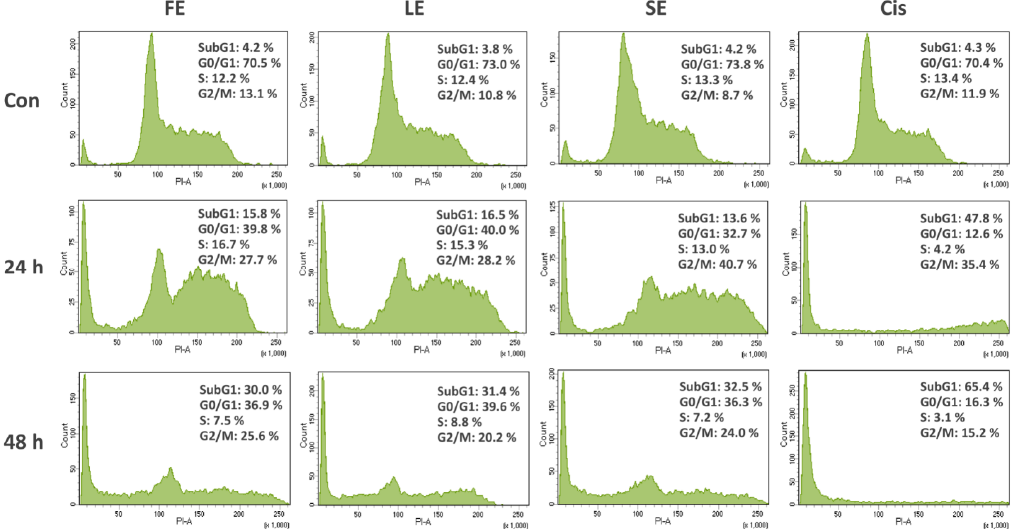
Figure 1. Cell cycle distribution at di ff erent phases (SubG1, G0 / G1, S, and G2 / M) of Caco-2 cells treated with extracts (0.20 mg / mL) and cisplatin (0.02 mg / mL) for 24 and 48 h and analyzed using flow cytometry after staining with PI (propidium iodide). Cis, cisplatin; Con, control (untreated cells). FE, floret extract; LE, leaf extract; SE, seed extract.